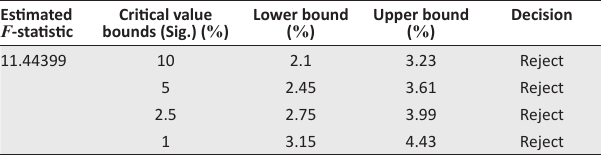
TABLE 5: Estimated Autoregressive Distributed Lag model bound test results. Estimated Critical value Lower bound F -statistic bounds (Sig.) ( % ) ( % )